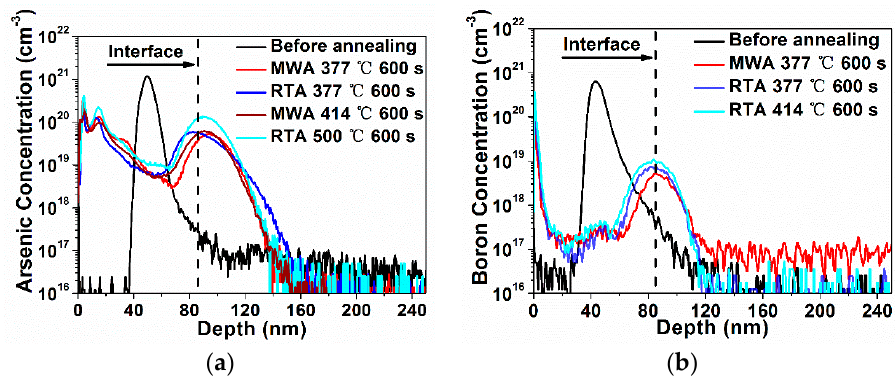
Figure 3. Secondary ion mass spectrometry (SIMS) profiles of ( a ) As dopants on p-type substrate; and ( b ) B dopants on n-type substrate before and after annealing.